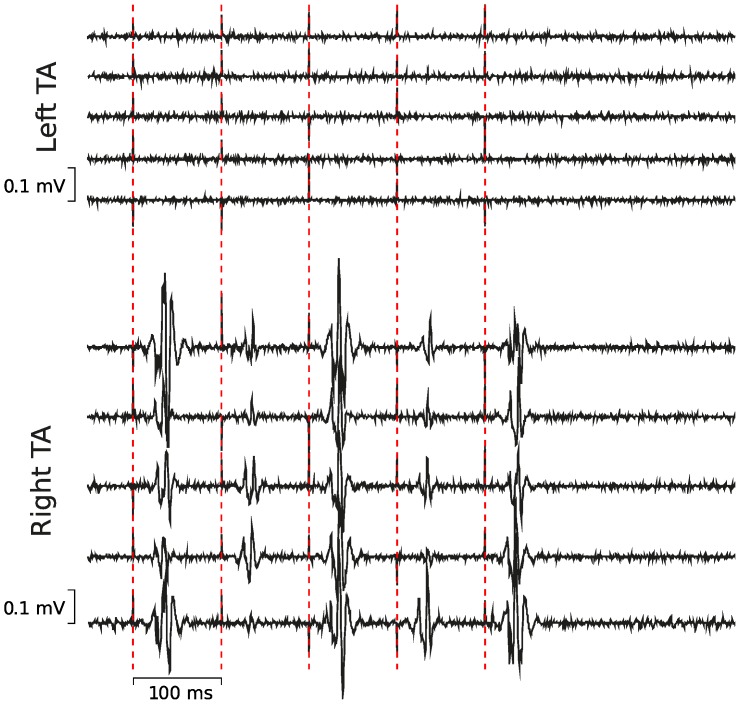
Control experiment (Experiment 3) was designed to rule out any spread of rTMS between hemispheres.While delivering rTMS over the left tibialis anterior (TA) M1 representation, we recorded MEPs in the right TA (bottom five traces) but not in the left TA (upper five traces). Vertical cursors are positioned at TMS pulses.